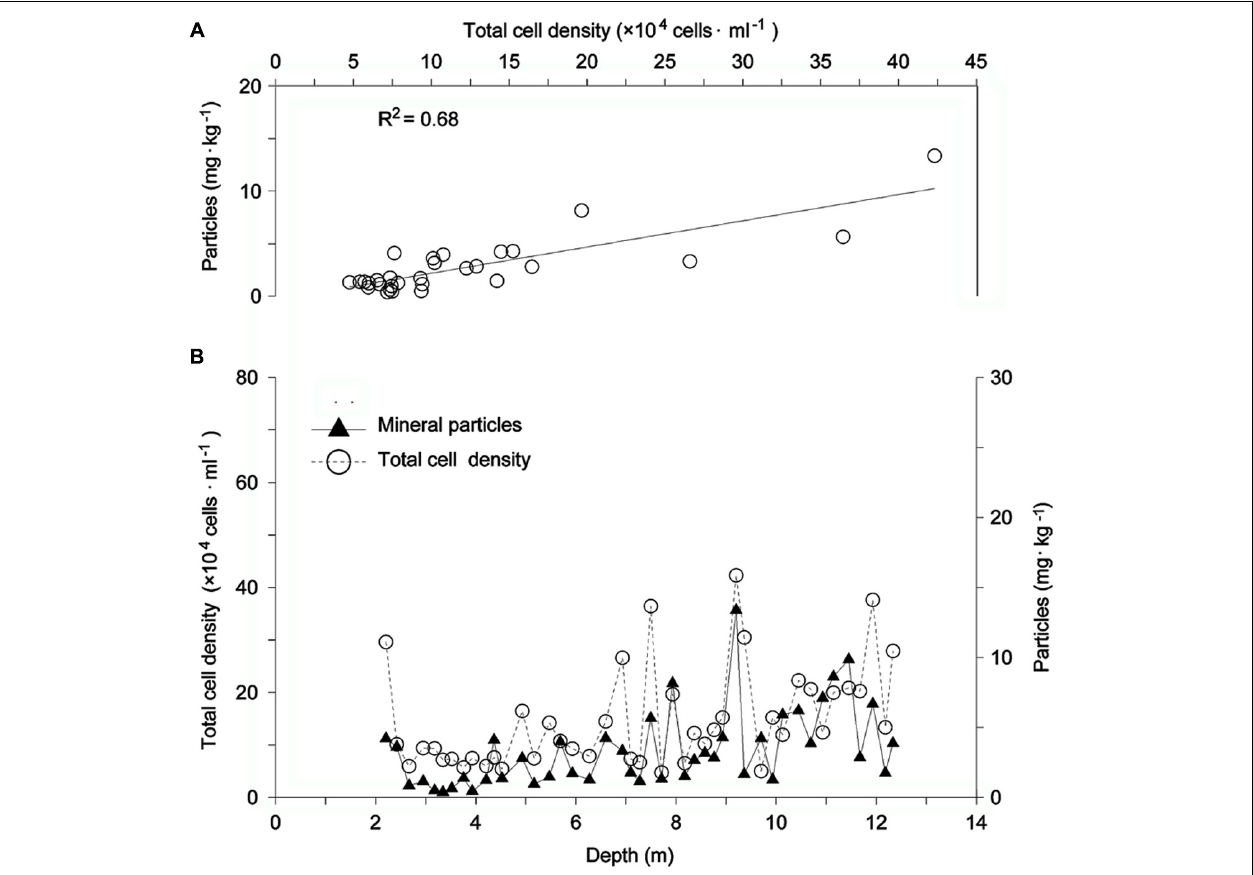
FIGURE 3 | Correlation between mineral particle concentrations and total cell density in the Muztagata ice core. (A) Correlation between total cell density and mineral particle concentrations at ice core depth 2.5–9.3 m. (B) Total bacterial cell density and mineral particle concentrations. Total microparticle concentrations were measured by using a Coulter counter Multisizer3